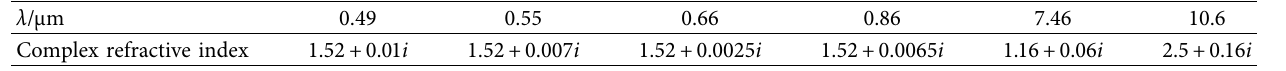
Table 1: The complex refractive index of Martian dust particles at typical wavelengths [11,